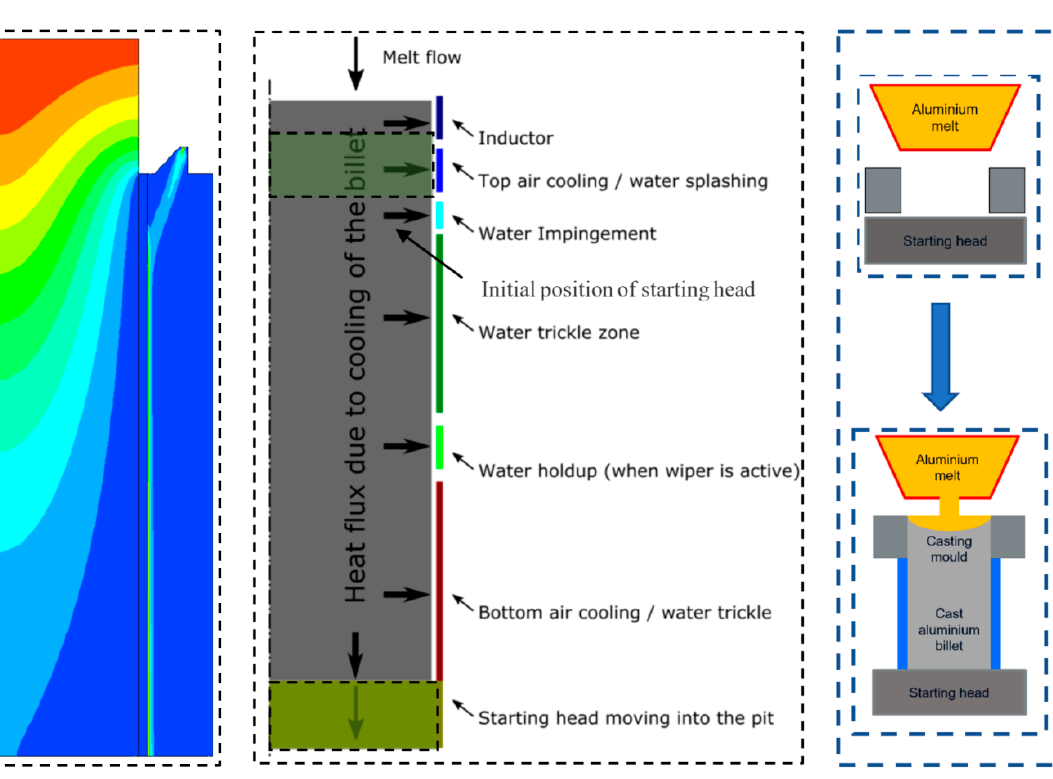
Table 3. Specifications of computational nodes and software used for all simulation scenarios. CPU